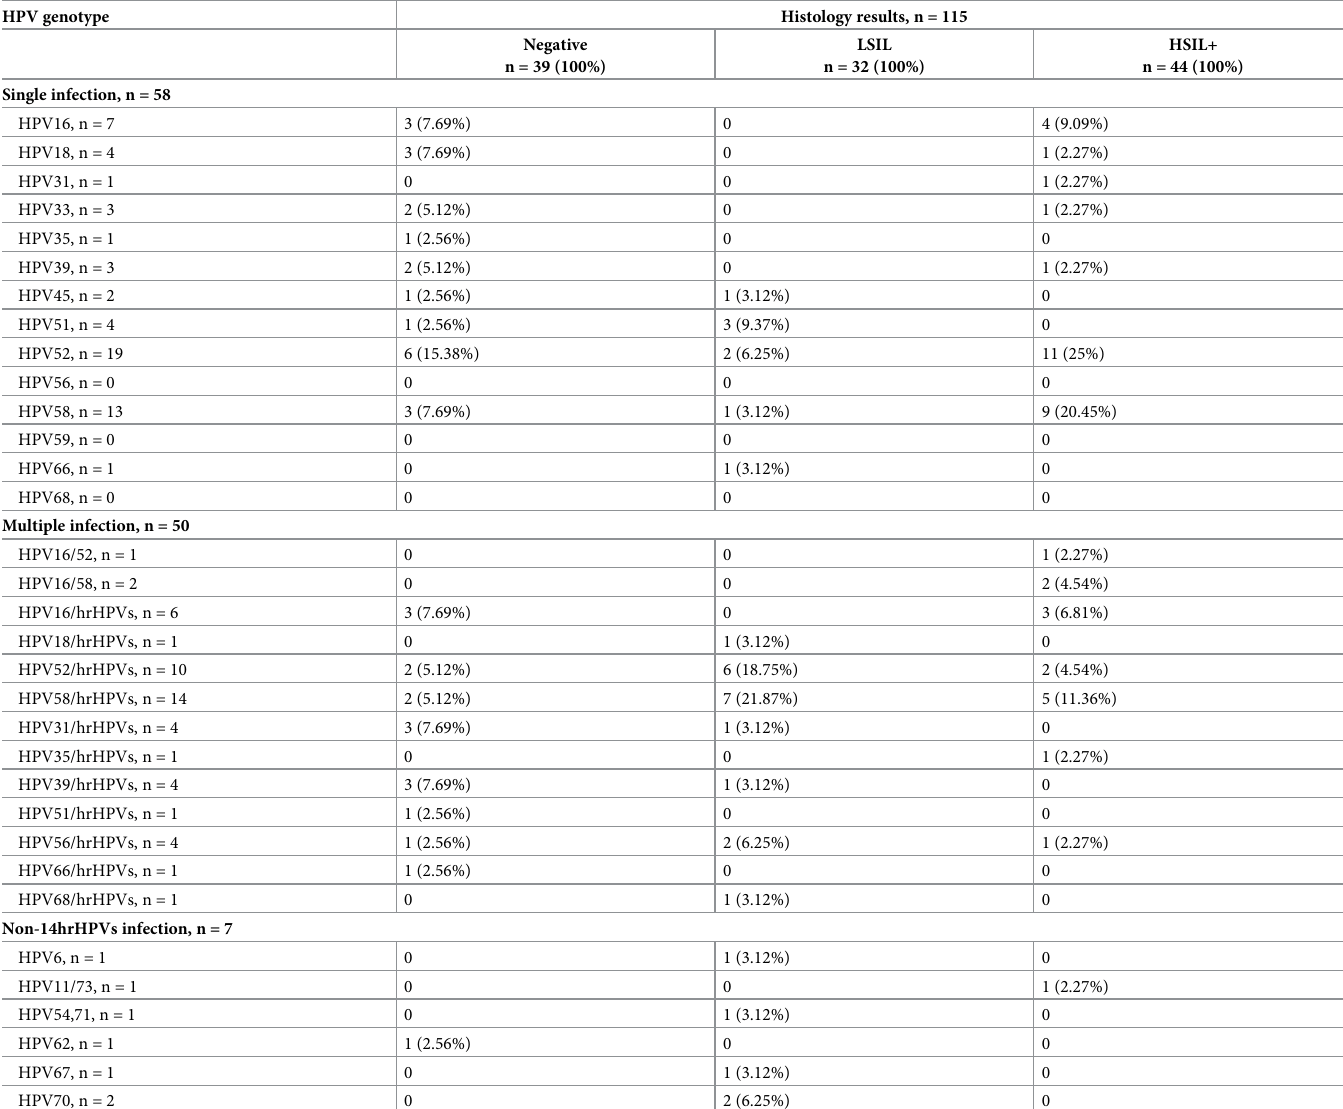
Table 4. Genotyping results of 115 women with available histology. HPV